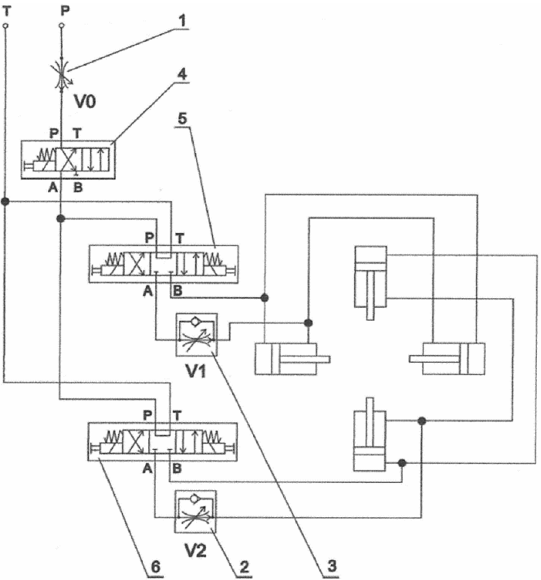
Figure 3. The hydraulic scheme of the loading device, where: 1-Manually operated Needle Valve, 2-Manually Operated Check Valve, 3-Manually Operated Check Valve, 4-Solenoid Operated Modular Valve,4-Way, 2-Position Crossover Offset, 5-Solenoid Operated Modular Valve, 4-Way, 3-Position Tandem Center, 6-Solenoid Operated Modular Valve,4-Way, 3-Position Tandem Center